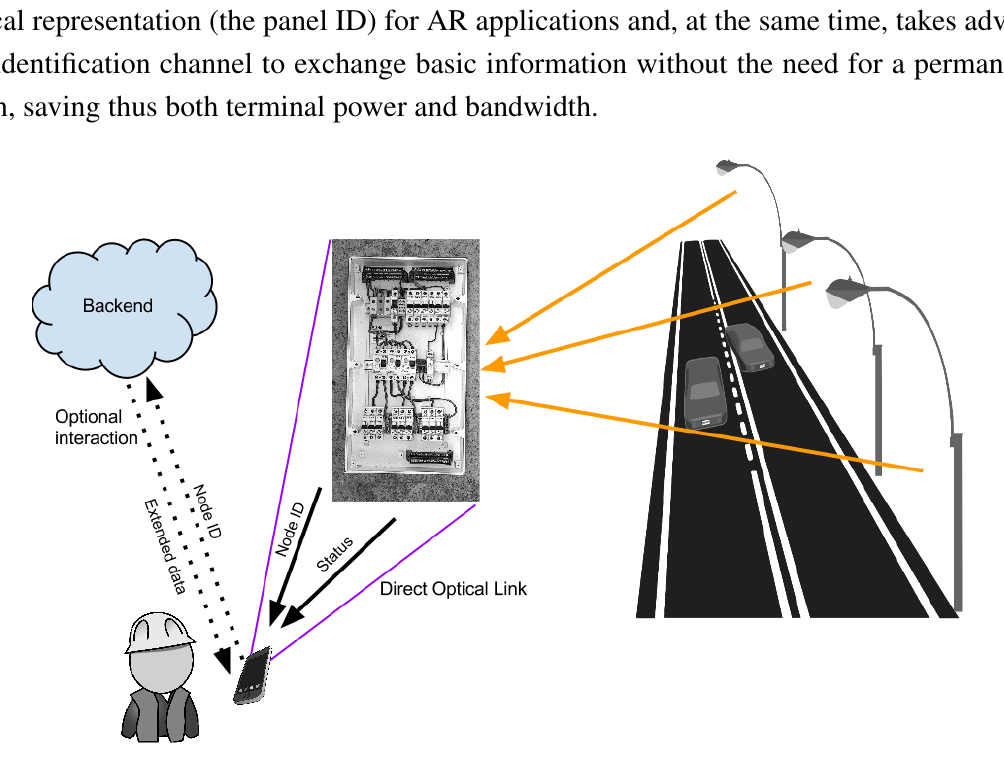
Figure 7. Use case for system